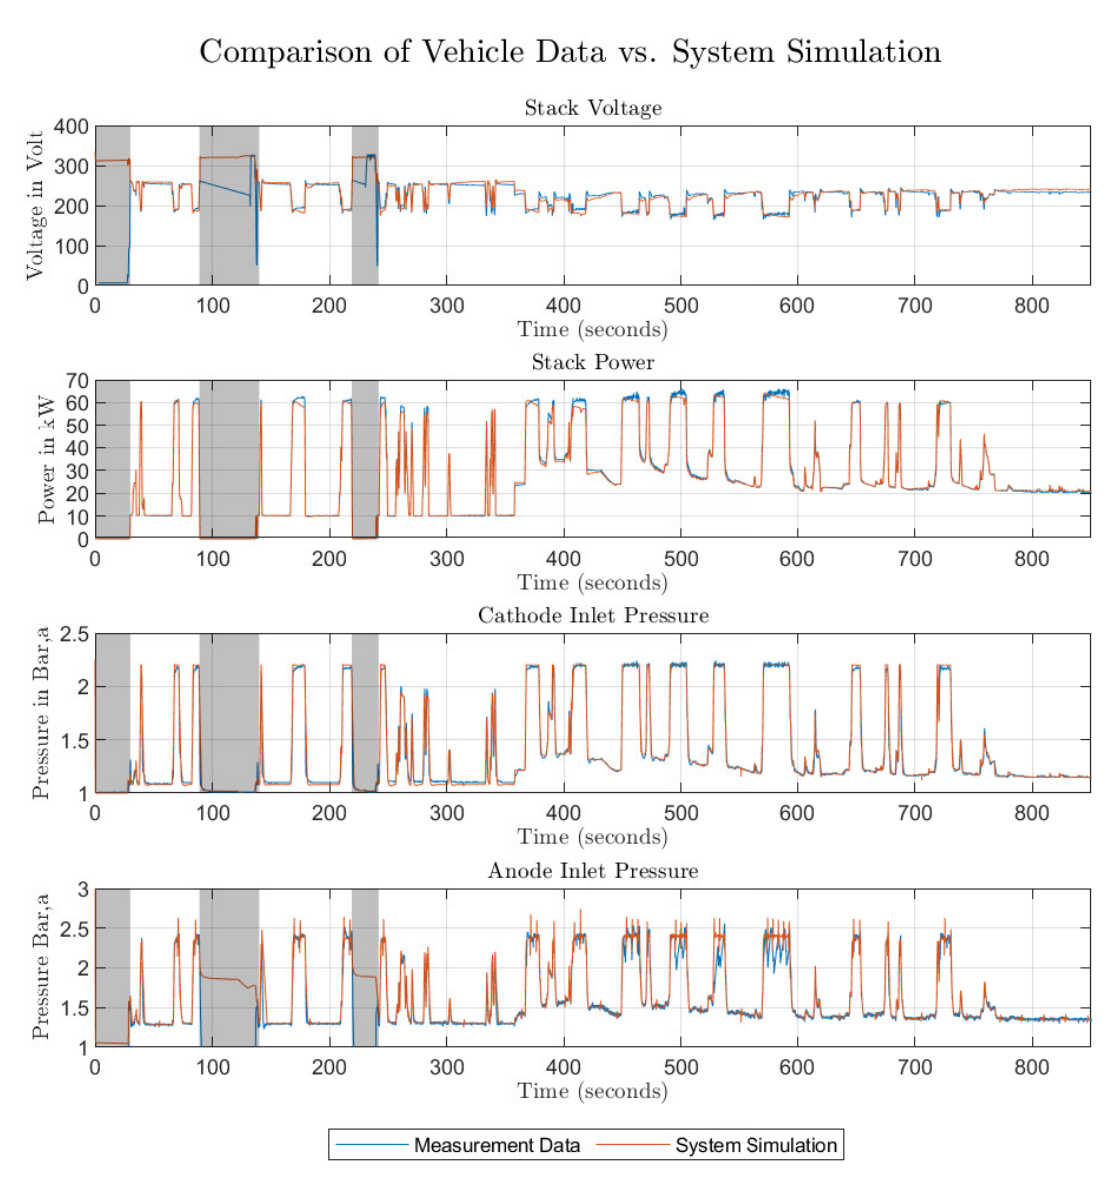
Figure 5. Comparison of measurement data from the Keytech4EV research vehicle to the outputs of the FC system simulation. Grey-shaded areas depict shutdown sequences which are out of the scope of the